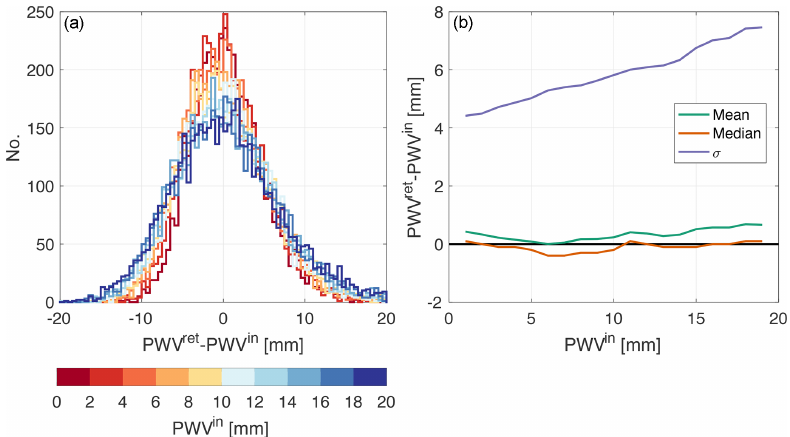
Figure 8. Errors on the retrieval of PWV. (a) Stacked histograms of the difference between the retrieved value, PWV ret , and the theoretical value used to construct the synthetic spectrum, PWV in , separated into different ranges of PWV in . (b) The mean values (in green), the median (in orange), and the standard deviation σ (in purple) for the same ranges of PWV in as in (a)